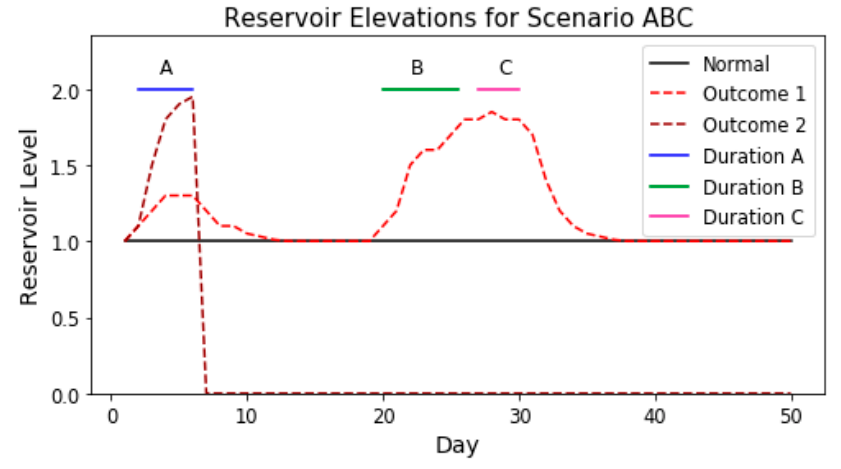
Figure 12. Example output reservoir elevations for Scenario ABC.